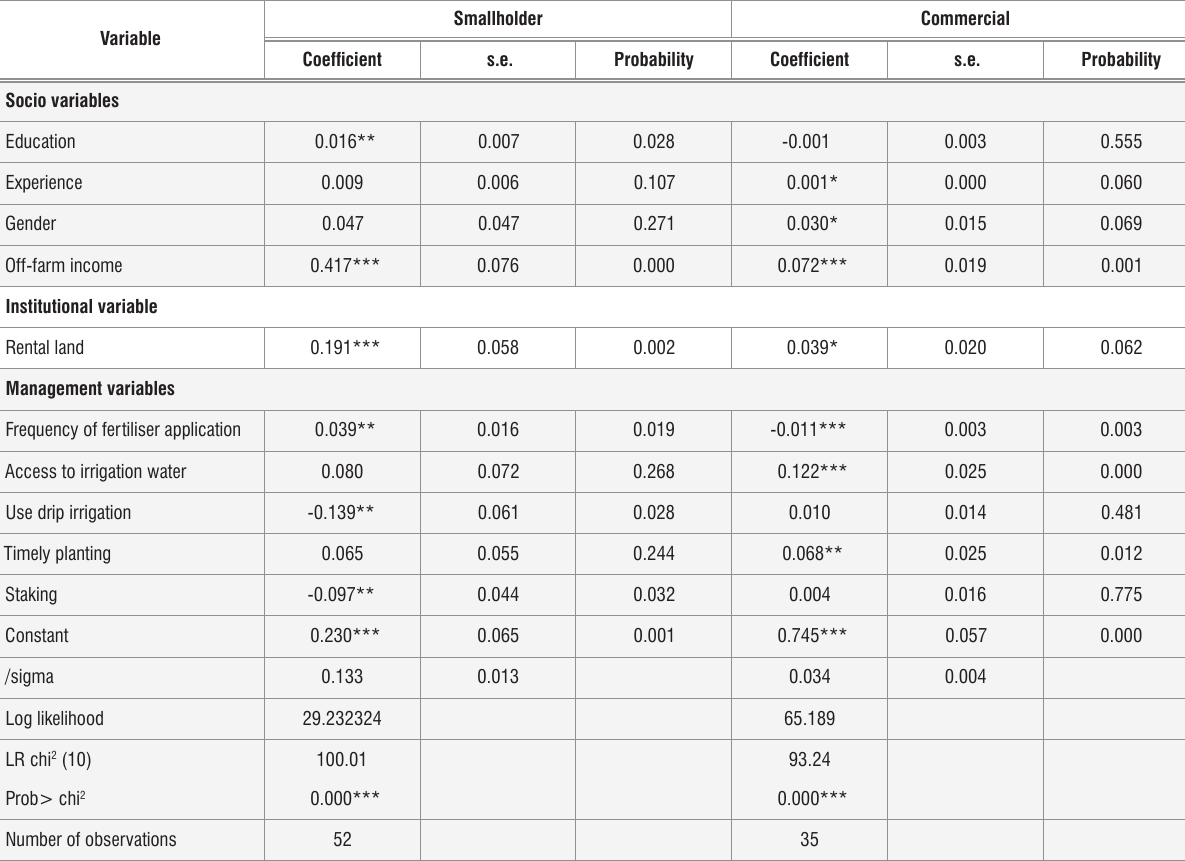
Table 3: Factors influencing technical efficiency for smallholder and commercial tomato